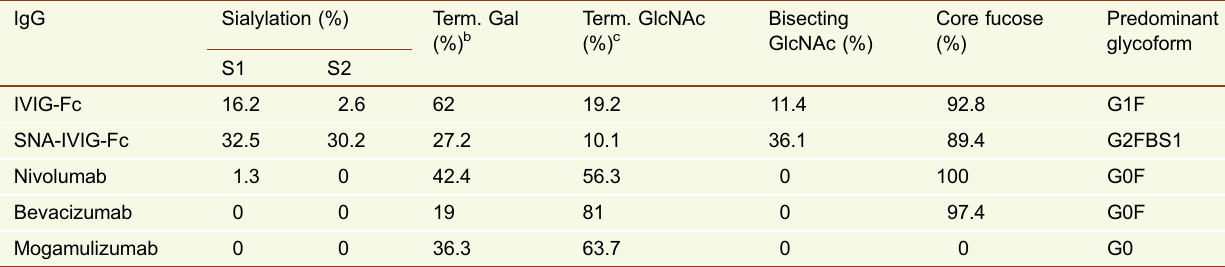
Table 1. Analysis of the key features of the N -glycans released from the therapeutic IgG antibodies a